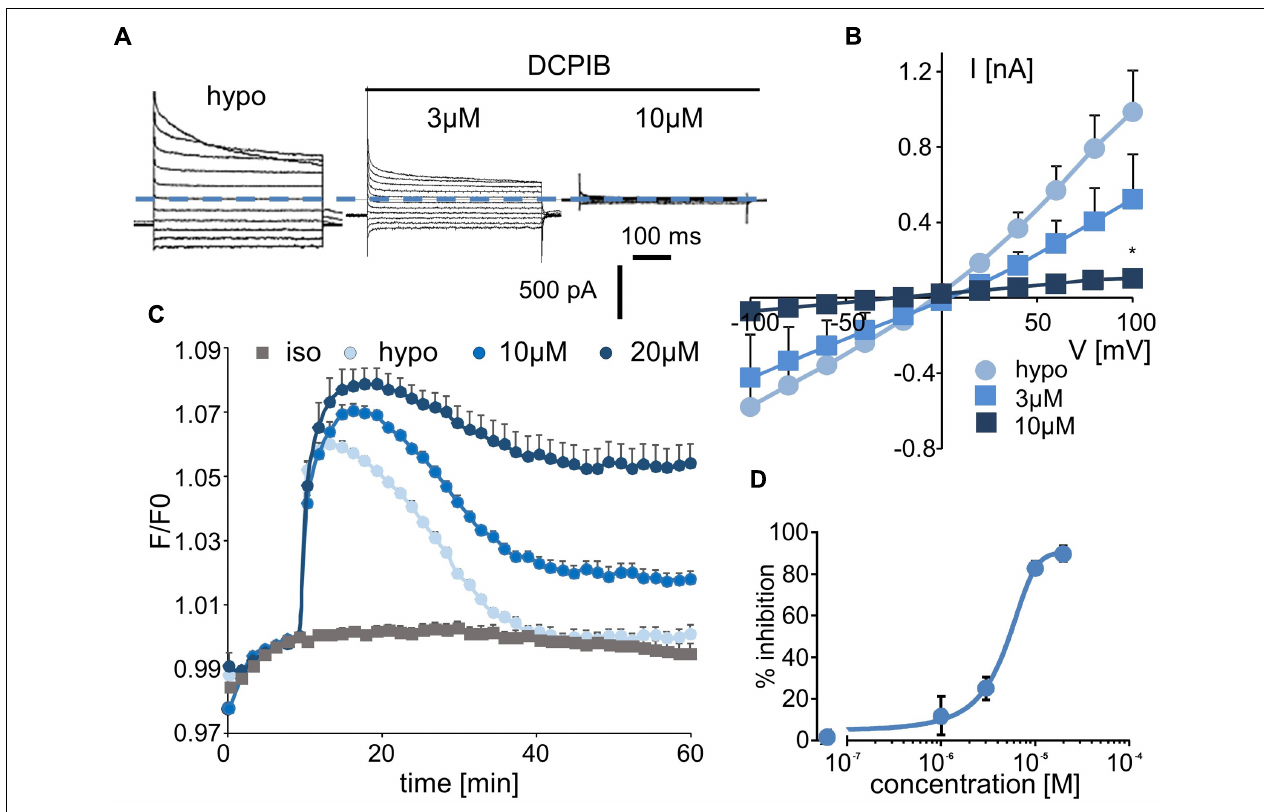
FIGURE 3 | Effect of DCPIB on I Cl , swell and on the RVD process. (A) Whole-cell current traces recorded from WT HEK-293 cells in hypotonic solution (hypo, 5 min) and in the presence of DCPIB at 3 and 10 µ M. (B) Mean current/voltage relationships measured at 10 ms after the onset pulse corresponding to experiments performed as in (A) in the absence or presence of increasing concentrations of DCPIB (3 and 10 µ M, n = 5 individual records for each concentration). (C) Inhibition by DCPIB (10 µ M, n = 12; 20 µ M, n = 8) of RVD following 100 mOsm.l − 1 hypotonic challenge based on calcein relative fluorescence. (D) Dose-response inhibition curves calculated from whole-cell current traces (A) obtained from cells exposed to 1, 3, 10, and 20 µ M DCPIB. The reported values are the mean ± SEM of 5 individual records obtained at each experimental concentration. The curves were calculated at –100 mV and permitted IC 50 calculation.